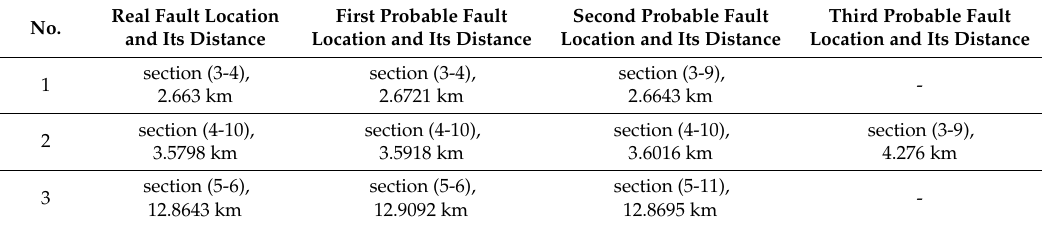
Table 1. Possible fault locations with zero resistance and different fault